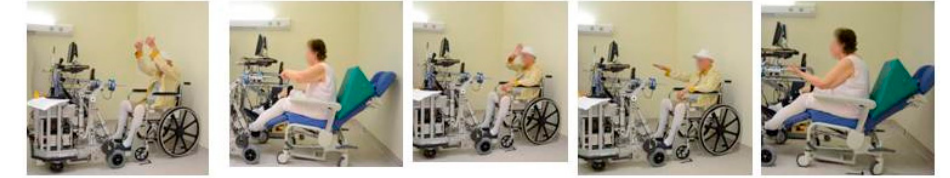
Figure 3. Participants performing the gestural commands set.